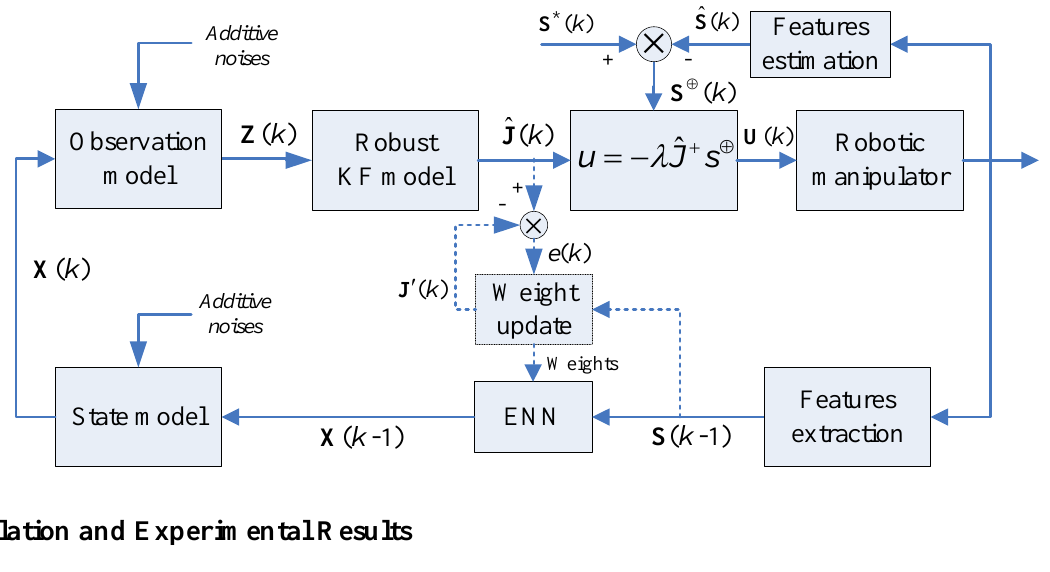
Figure 4. The scheme of global-state-space IBVS, which is attached to a Robust KF Cooperate with ENN learning. Online weights update to ensure robotic global stability